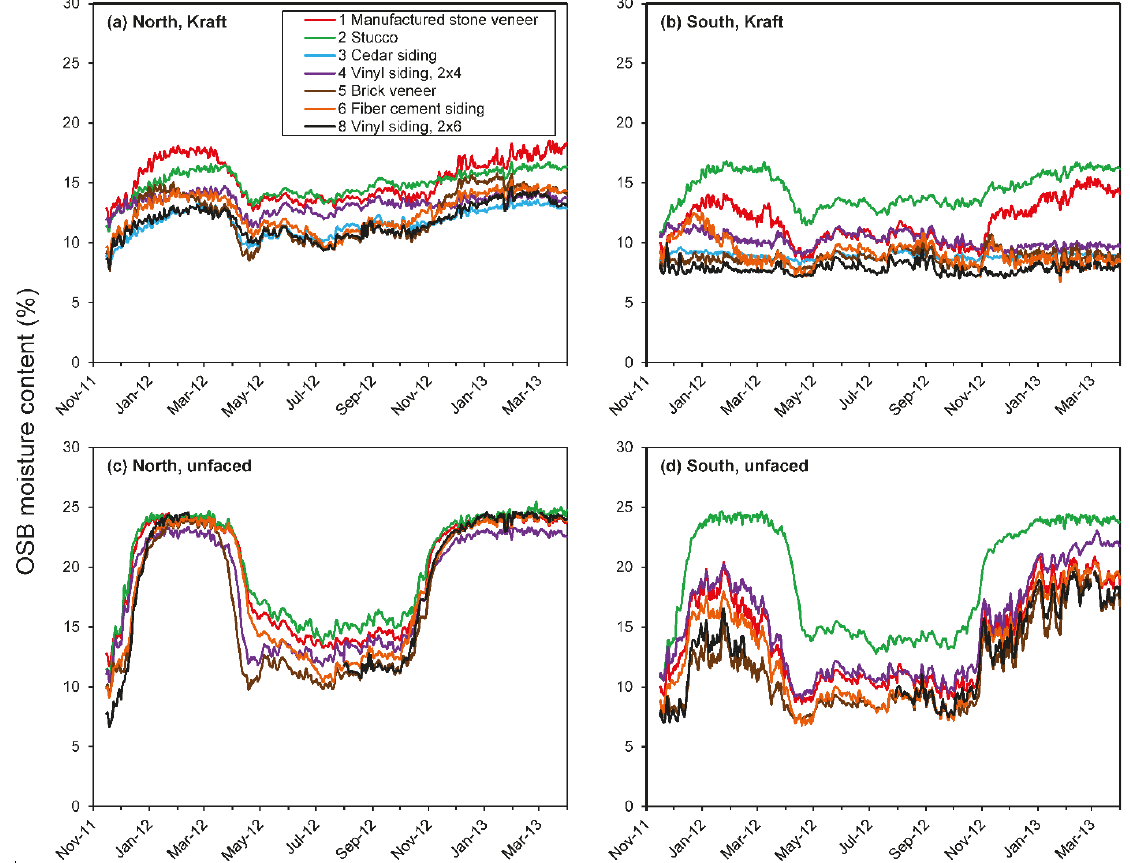
Figure 6. OSB moisture content measured in ( a ) North-facing walls with kraft-faced batts; ( b ) South-facing walls with kraft-faced batts; ( c ) North-facing walls with unfaced batts; and ( d ) South-facing walls with unfaced